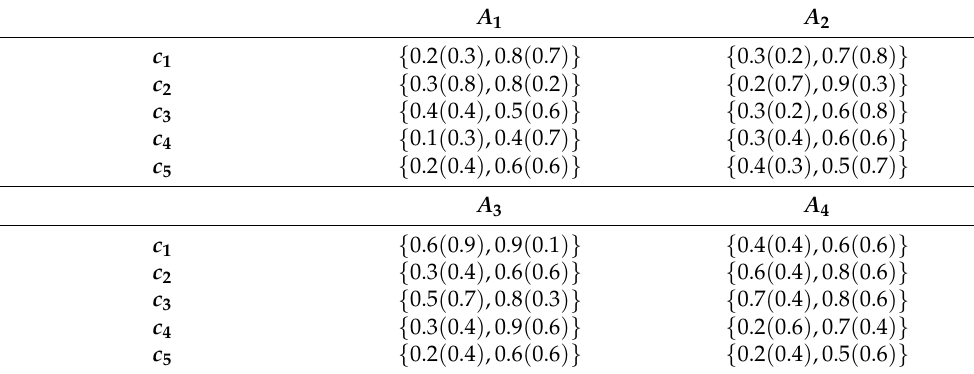
Table 1. Original evaluation matrix of Expert 1 ( d 1 ).